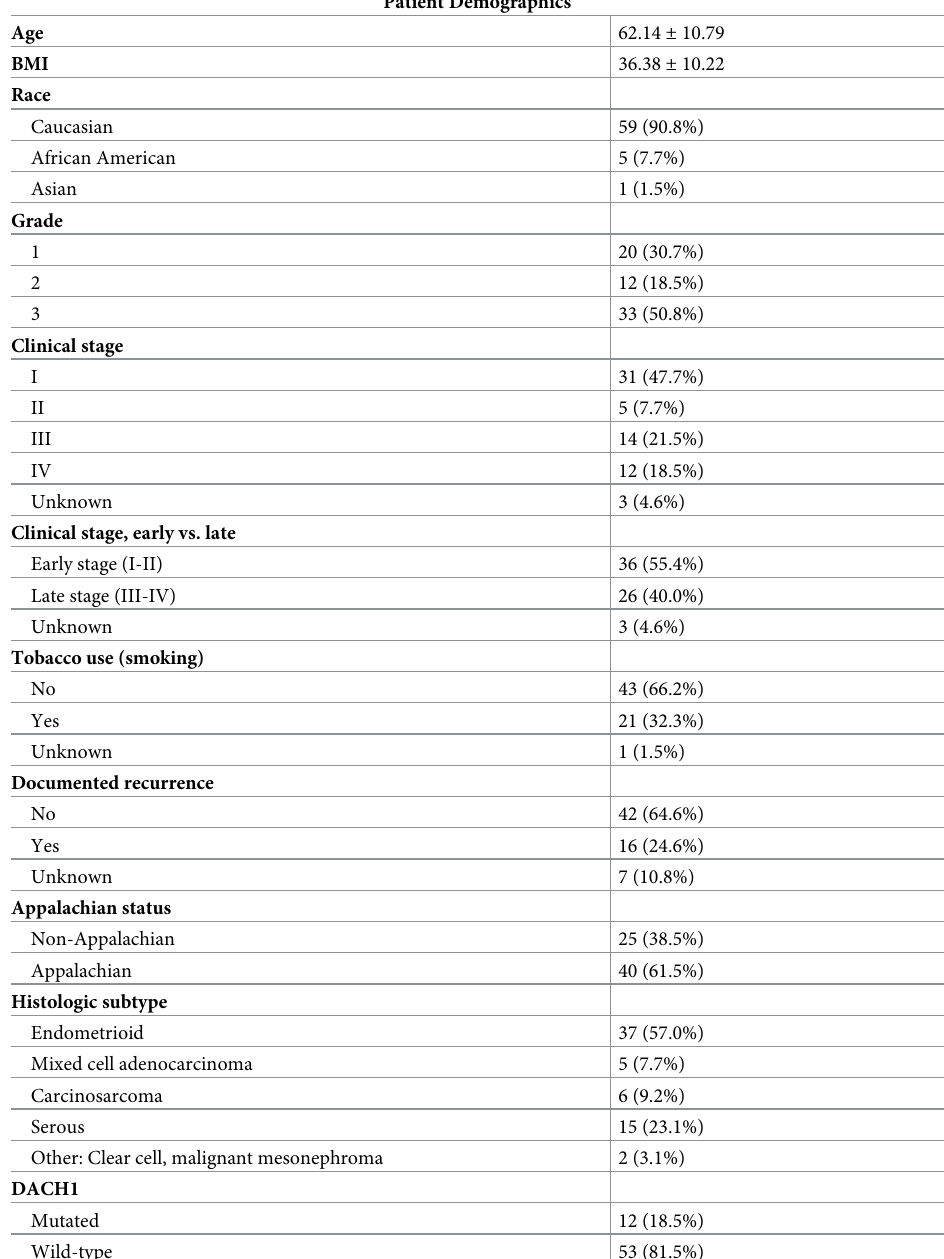
Table 1. Demographics of the Markey Cancer Center